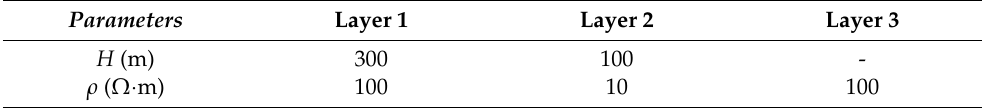
Table 1. Parameters of H-type